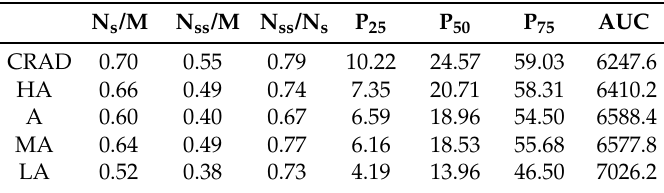
Table 2. Parameters from the scaffold diversity analysis of CRAD and the subgroups of NAA (HA, A, MA and LA) (using Murcko